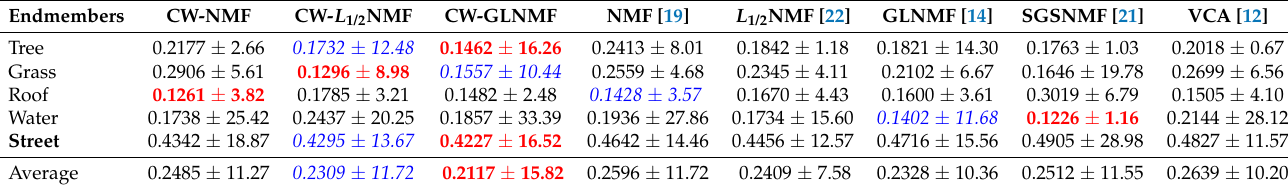
Figure 9. Endmembers of HYDICE Washington DC Mall estimated by CW-NMF, CW- L 1/2 NMF, and CW-GLNMF methods. Black solid lines denote the reference endmembers and red double- dashed lines denote the estimated endmembers by CW-NMF. Besides, the other two estimated endmembers (CW- L 1/2 NMF, CW-GLNMF) are represented by blue dotted lines and cyan dashdot lines, respectively. Table 1. Performance comparison on the HYDICE Washington DC Mall data, where the red bold and blue italic fonts denote the best and second-best results, respectively. In addition, the black bold letters represent the imbalanced